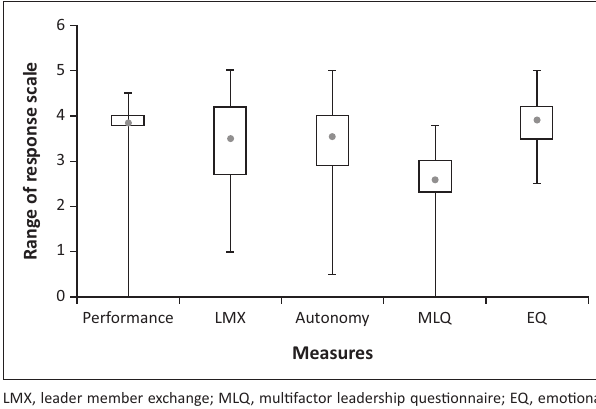
FIGURE 2: Box and whisker plot indicating distribution of factor scores for each